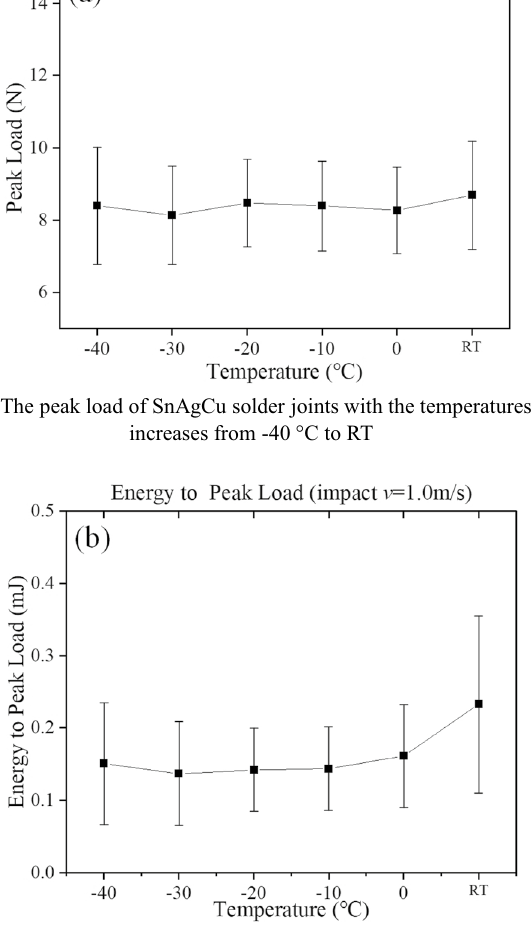
Figure 7 Low temperature micro-impact test of SnAgCu BGA solder joints [43]